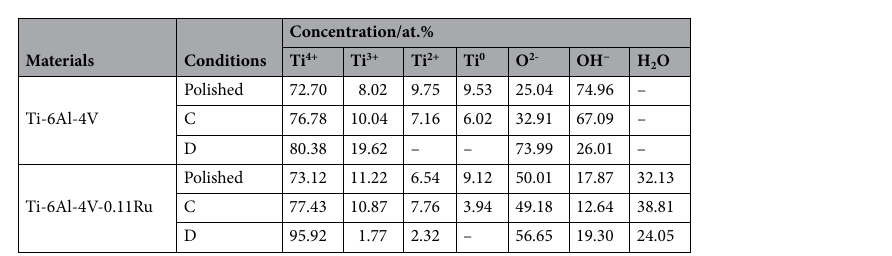
Figure 12. Deconvoluted O 1s XPS spectra for ( a ) Ti-6Al-4V and ( b ) Ti-6Al-4V-0.11Ru under different conditions.